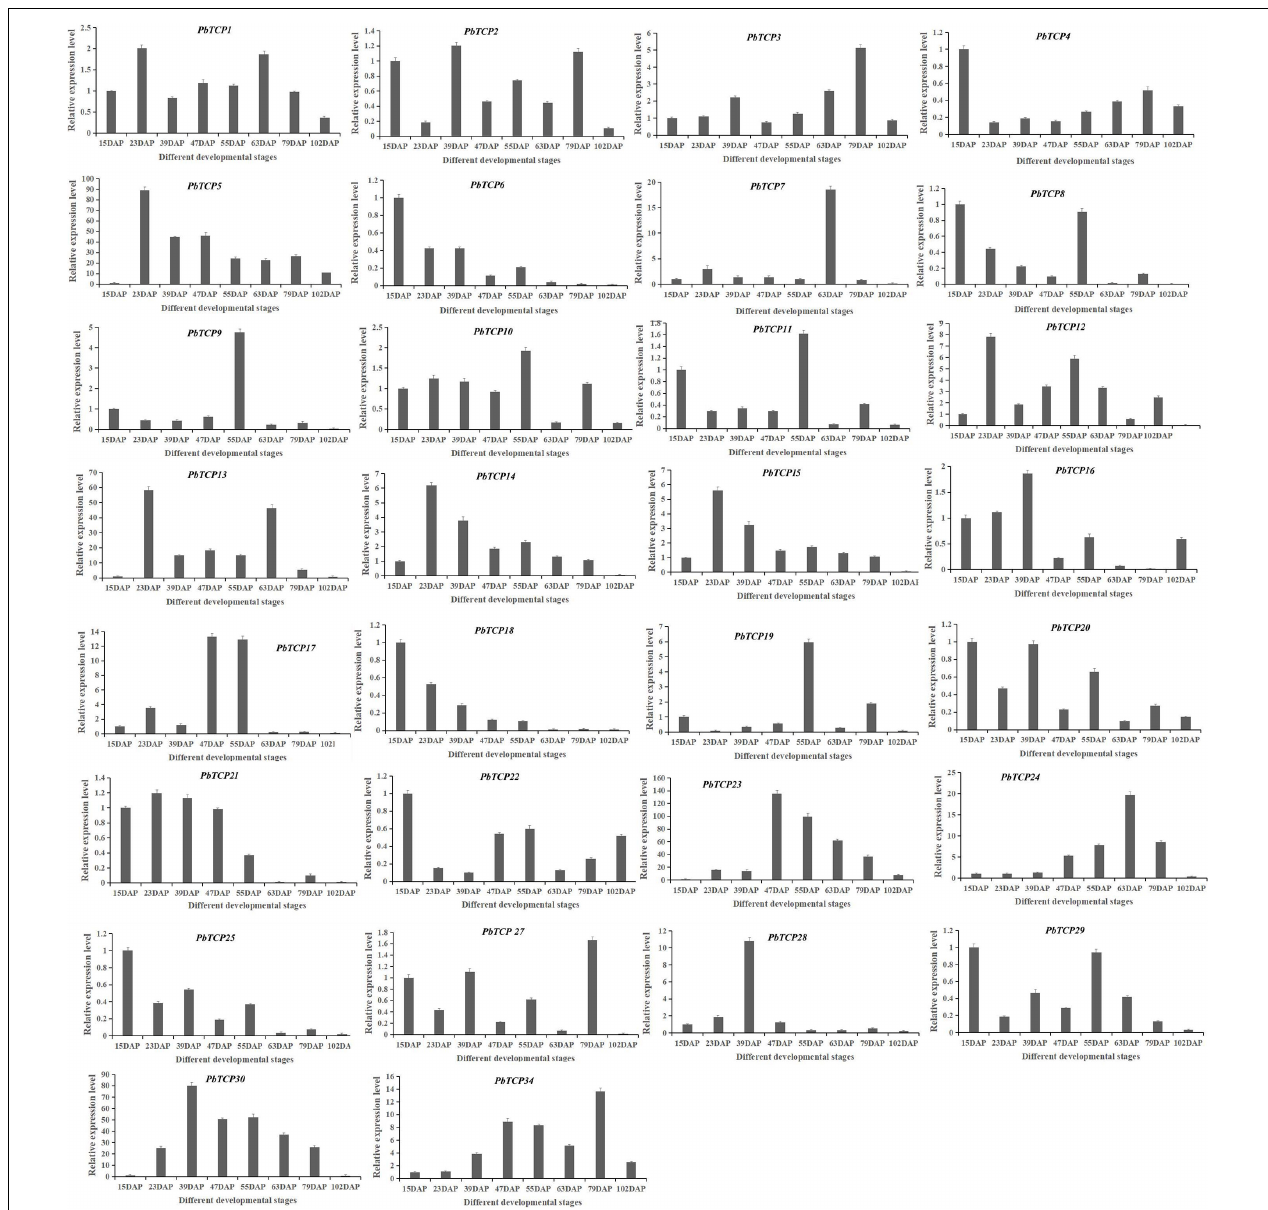
FIGURE 8 | Expression pattern of PbTCPs across different developmental stages (15DAP, 23DAP, 39DAP, 47DAP, 55DAP, 63DAP, 79DAP, and 102DAP). Error bars show the standard error between three